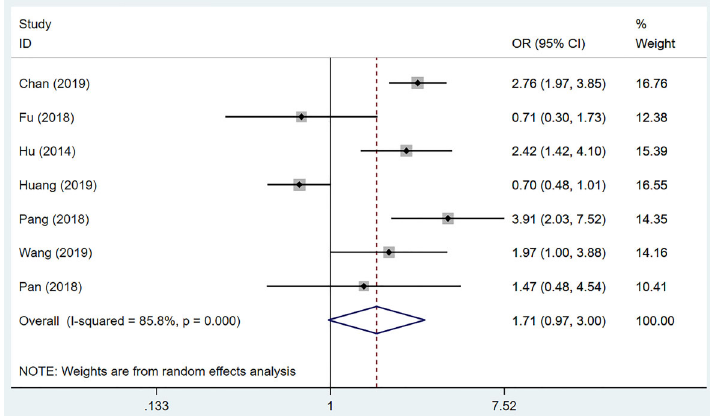
Figure 2. Forest plot of the relationship between preoperative systemic immune-in fl ammation index and vascular invasion in patients with hepatocellular carcinoma. See Supplementary Table S2 for reference numbers.